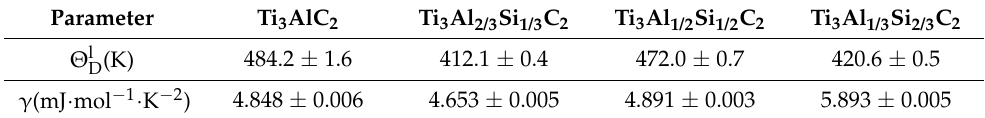
Table 3. The approximated Debye temperatures ( Θ l ) and Sommerfeld coefficients ( γ ) determined D from linear fits of the low temperature C p / T vs. T 2 plots ( T < 7K) for the Ti 3 (Al 1 − x Si x )C 2 compounds.